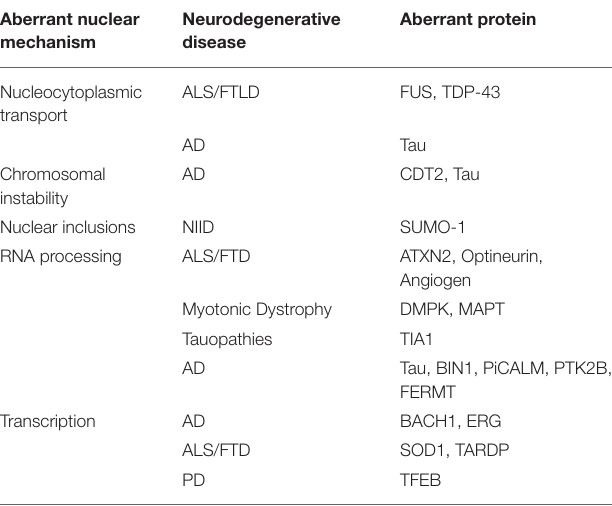
TABLE 1 | Specific neurodegenerative diseases and aberrant proteins associated with each mechanism. Aberrant nuclear